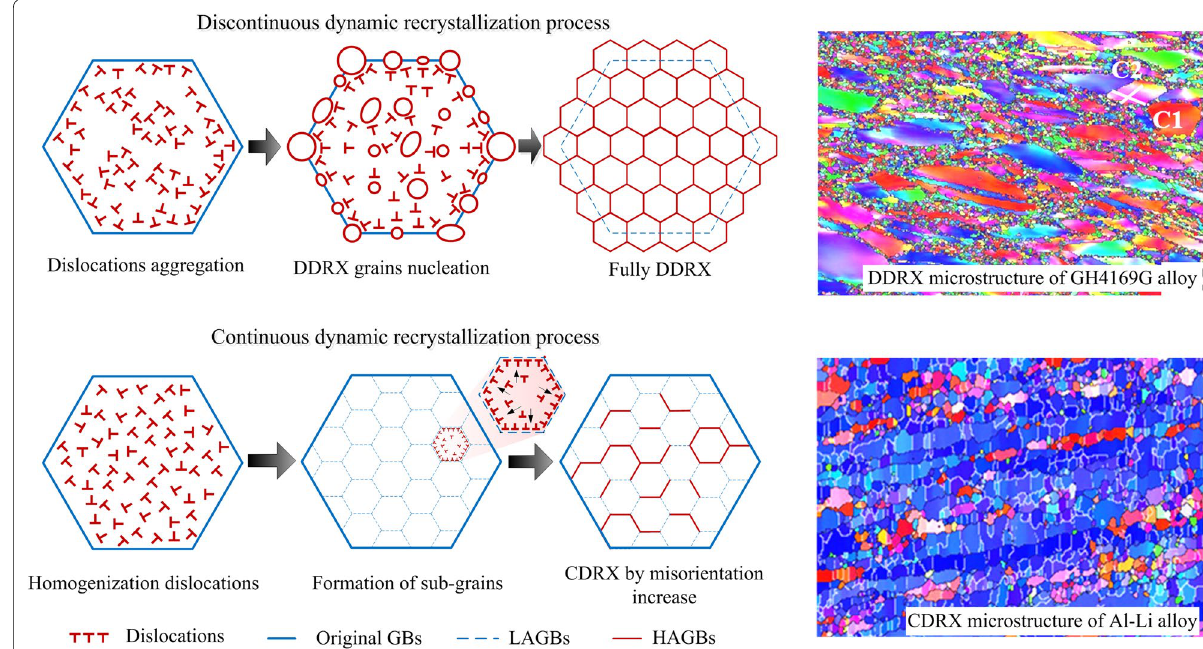
Figure 8 Schematic diagrams for the evolution mechanisms of DDRX and CDRX (The microstructure picture of DDRX was reproduced from Ref.